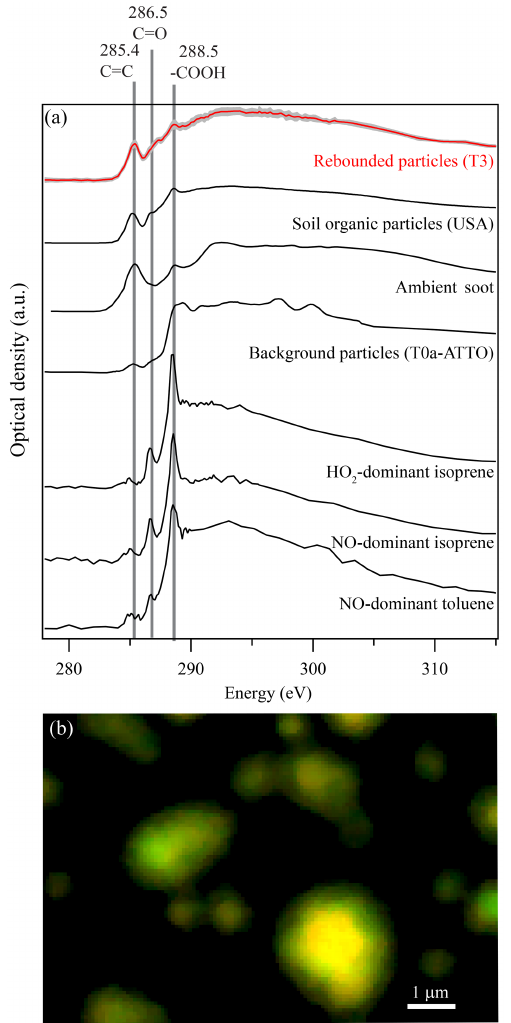
Figure 11. STXM/NEXAFS analysis of particles collected after re- bound from the impaction plate. Samples were collected between 01:00 and 10:00UTC on 1 October 2014. (a) Carbon K-edge spec- trum of rebounded particles (red). Lines at 285.4 and 288.5eV highlight absorption by double bonds (C = C) and carboxylic acids (-COOH), respectively. The line in the region of 286.5 to 286.7eV can have contributions from ketones, carbonyl-substituted aromat- ics, and phenolic species. For comparison, spectra are shown for carbonaceous particles collected in other field and laboratory stud- ies: soil organic particles from the central USA (Wang et al., 2016), soot from the ambient environment, atmospheric particles collected at a background site in central Amazonia (Pöhlker et al., 2012), and three laboratory samples of secondary organic mate- rial. Data sources: isoprene-derived SOM produced under HO 2 - dominant conditions (O’Brien et al., 2014); isoprene-derived SOM produced under NO-dominant conditions (O’Brien et al., 2014), and toluene-derived SOM produced under NO-dominant conditions (this study). (b) STXM image from which the NEXAFS spectrum of panel (a) was obtained. Coloring is red for absorption at 285.4eV (i.e., double bonds). Coloring is green for other types of functional- ities. The pixelation visible in the image corresponds to the STXM spatial resolution during data